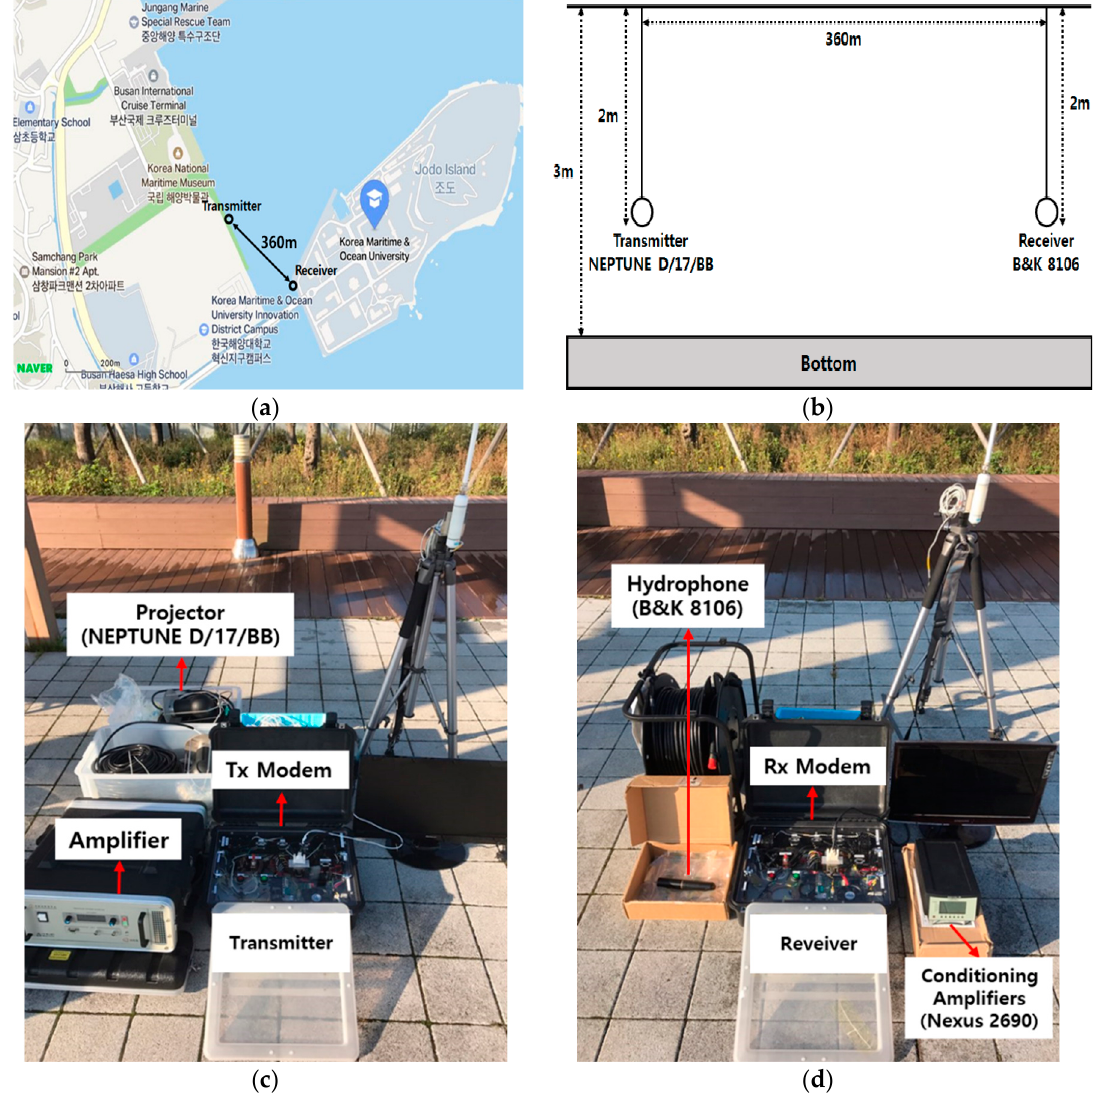
Figure 3. Illustration of the sea trial: ( a ) Area map of the sea trials, ( b ) experimental setup schematic, ( c ) transmission equipment, ( d ) receiver equipment.